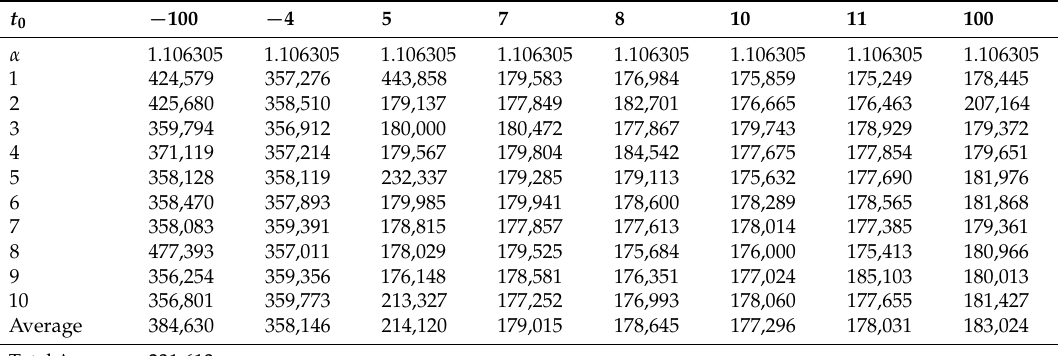
Table 9. Running time for different initial values of Example 4 by the H-H-H method.